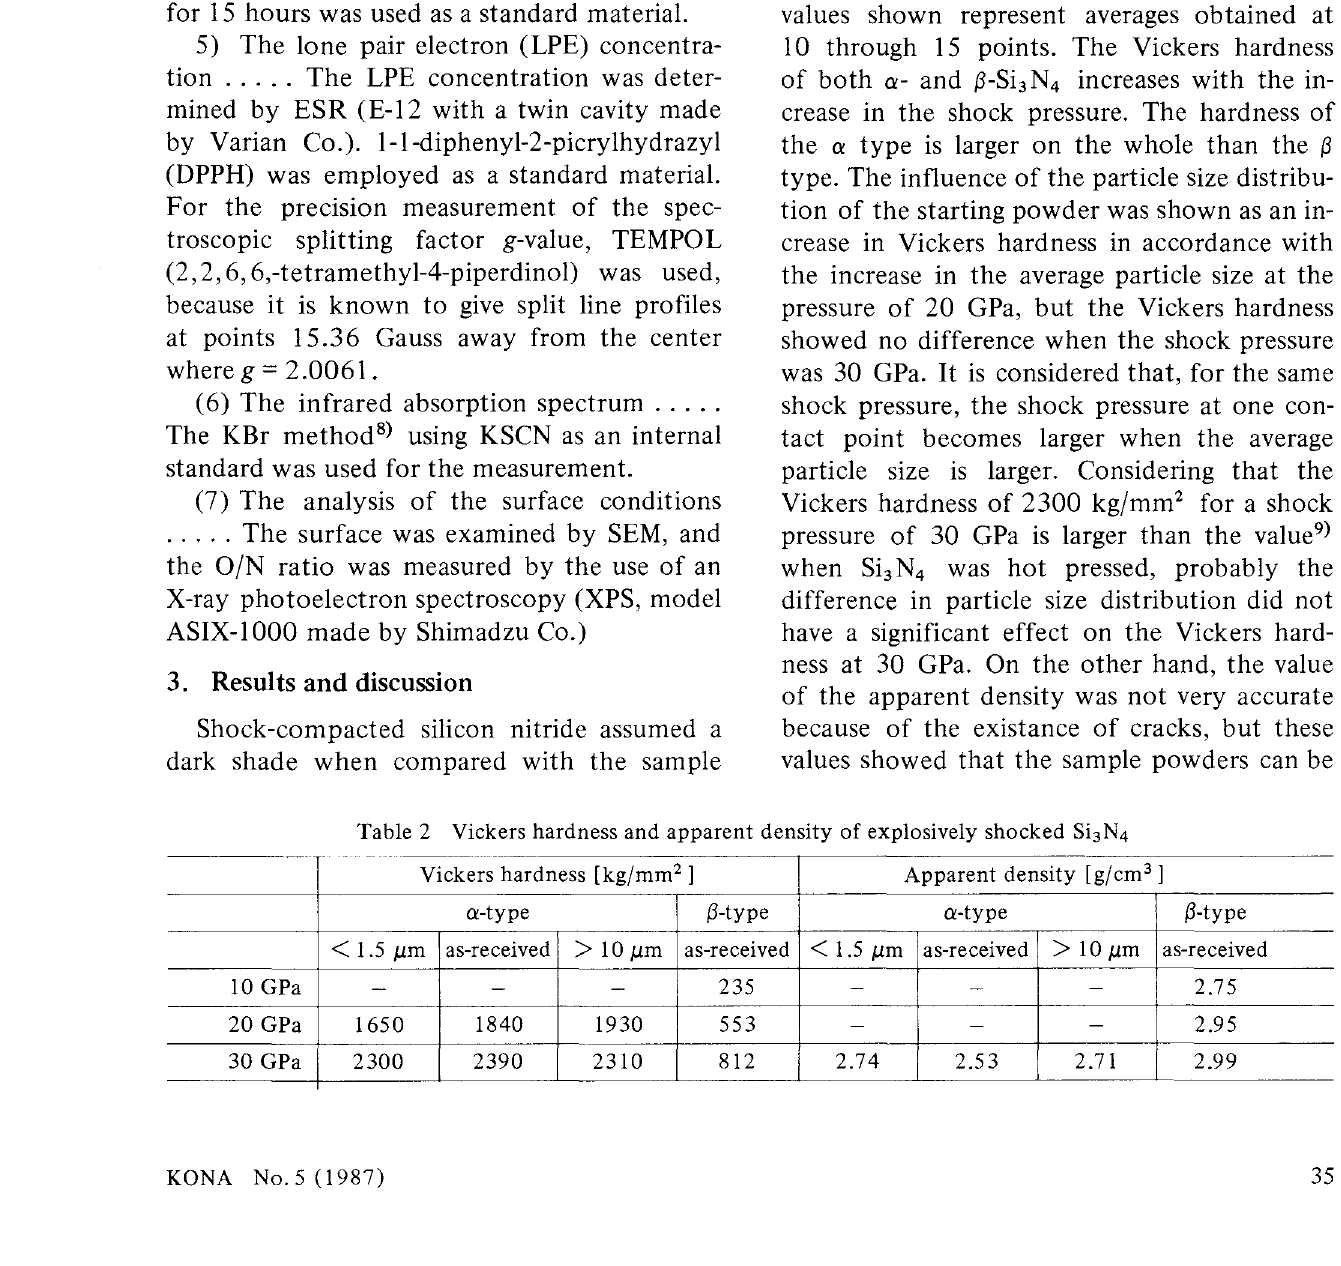
Fig. 3 Photograph of recovered Si